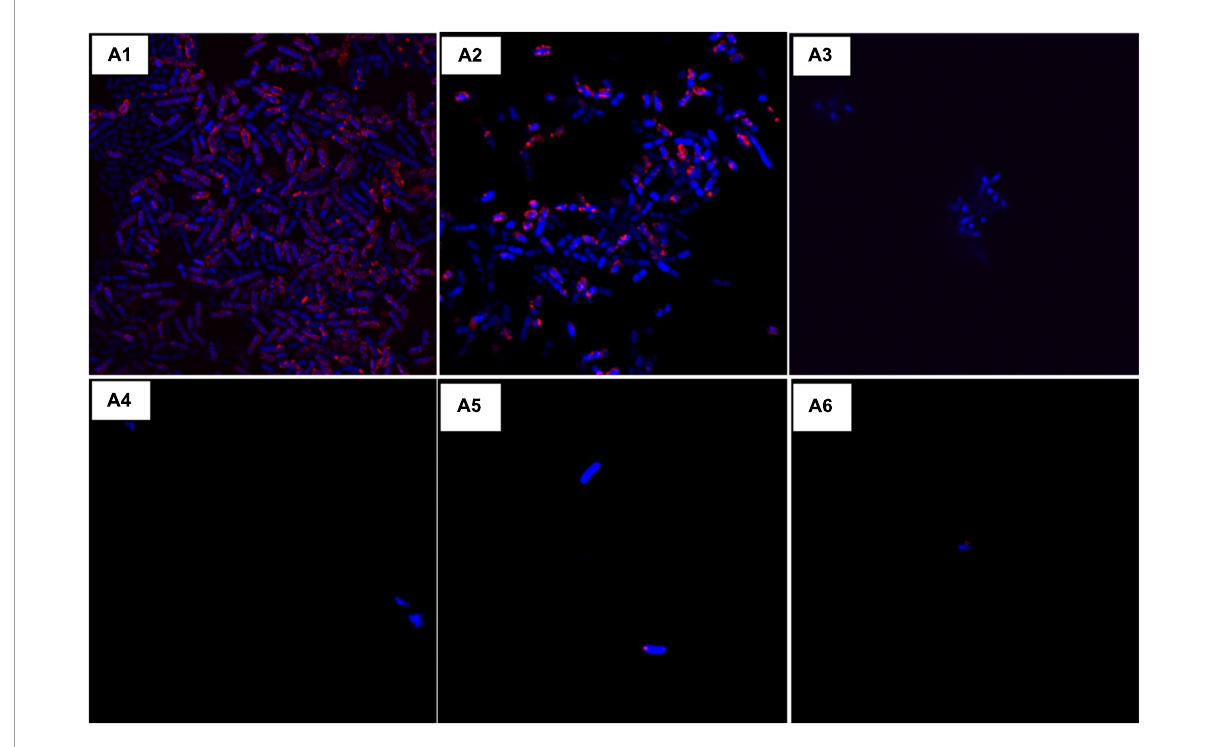
FIGURE4 Confocal laser scanning microscopy (CLSM): Morphological changes when using the combination of AD-L@Ag(0) + colistin were observed using CLSM and compared with the controls. Here, (A1) : Acinetobacter baumannii control (AB-C), (A2) : Colistin control (CC), (A3) : Nano-formulation control [AD-L@Ag(0)] (NF–C), (A4) : 1 / 2 MIC col + 1 / 4 MIC AD − L@Ag ( 0 ) , (A5) : 1 / 4 MIC col + 1 / 2 MIC AD − L@Ag ( 0 ) , and (A6) : 1 / 4 MIC col + MIC AD − L@Ag ( 0 ) . The results were consistent with our previous observations. Colistin MIC concentration showed visible growth of AB (A2) and MIC of AD-L@Ag(0) shows no visible bacteria due to bactericidal effect (A3) . Whereas, the combination of two at 1 / 2 MIC col + 1 / 4 MIC AD − L@Ag ( 0 ) (A4) bacterial growth was inhibited. That is why there is negligible number of bacteria visible under confocal